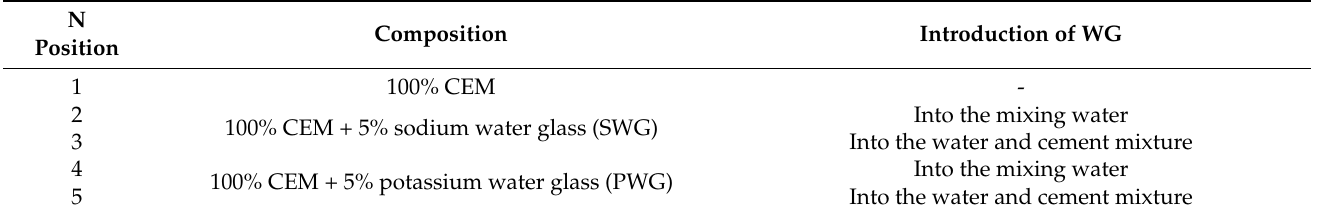
Table 3. Various options for introducing sodium and potassium water